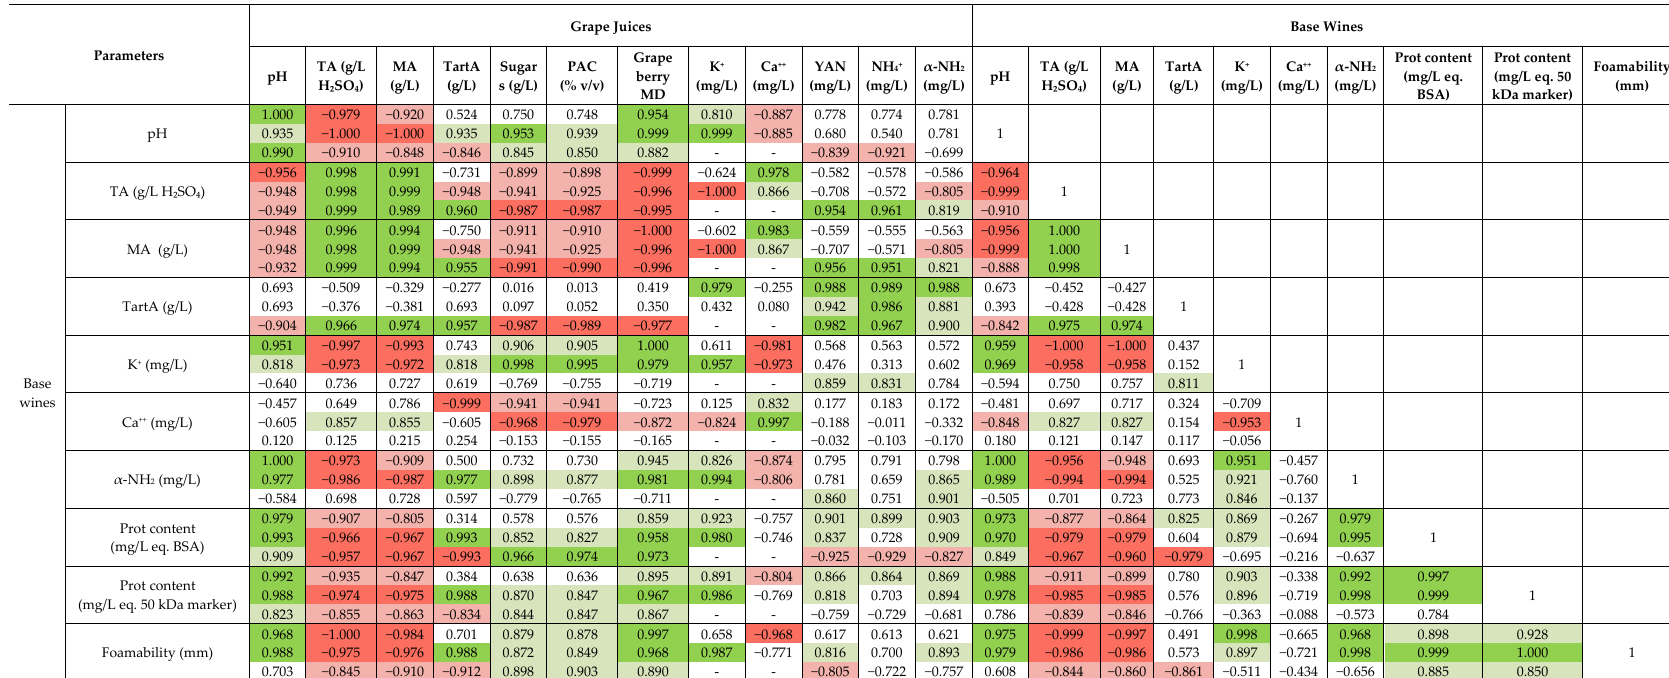
Table 4. Cont. Table 4.